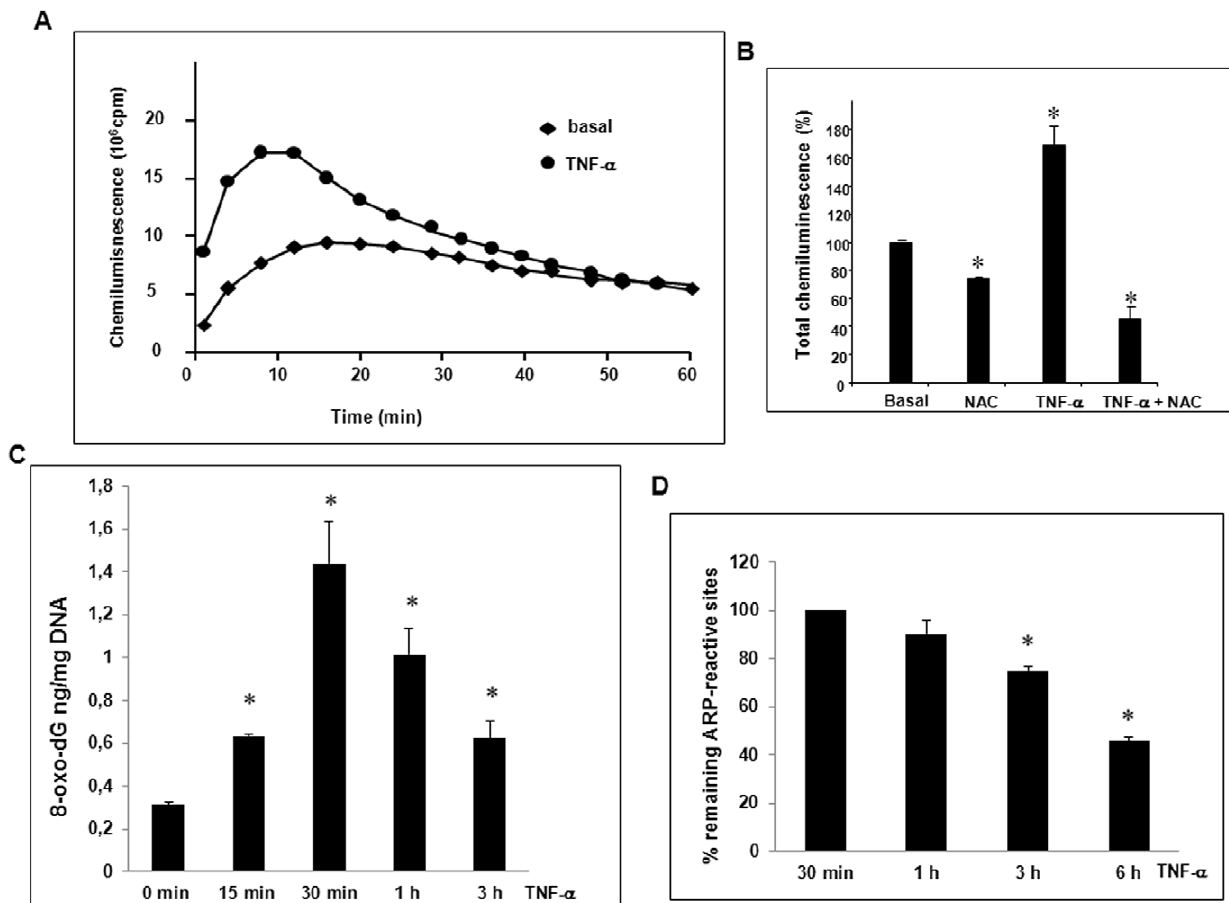
Figure 3. TNF- a induced ROS, 8-oxo-dG production and mtDNA repair. (A) TNF- a induced extra and intracellular ROS were measured over 1 h-period using LAC assay on cell suspension (10 6 cells in 0.5 ml Hanks buffer) as described in Materials and Methods. One representative experiment of four independent studies is shown. (B) Chemiluminescence is also quantified at the peak in the absence or presence of 5 mM NAC as a percentage of basal value (control) (mean 6 SEM for three independent experiments, *p , 0.05). (C) TNF- a induced levels of 8-oxo-dG after 15 min to 3 h cell treatment were measured using the OxiSelect TM Oxidative DNA damage ELISA kit (mean values 6 SEM of three independent experiments *p , 0.05). (D) The decrease of mtDNA remaining ARP-reactive sites created at 30 min TNF- a treatment (100%) was measured from 1 to 6 h using the OxiSelect TM oxidative DNA damage quantitation kit (mean values 6 SEM of three independent experiments *p , 0.05 vs 30 min).